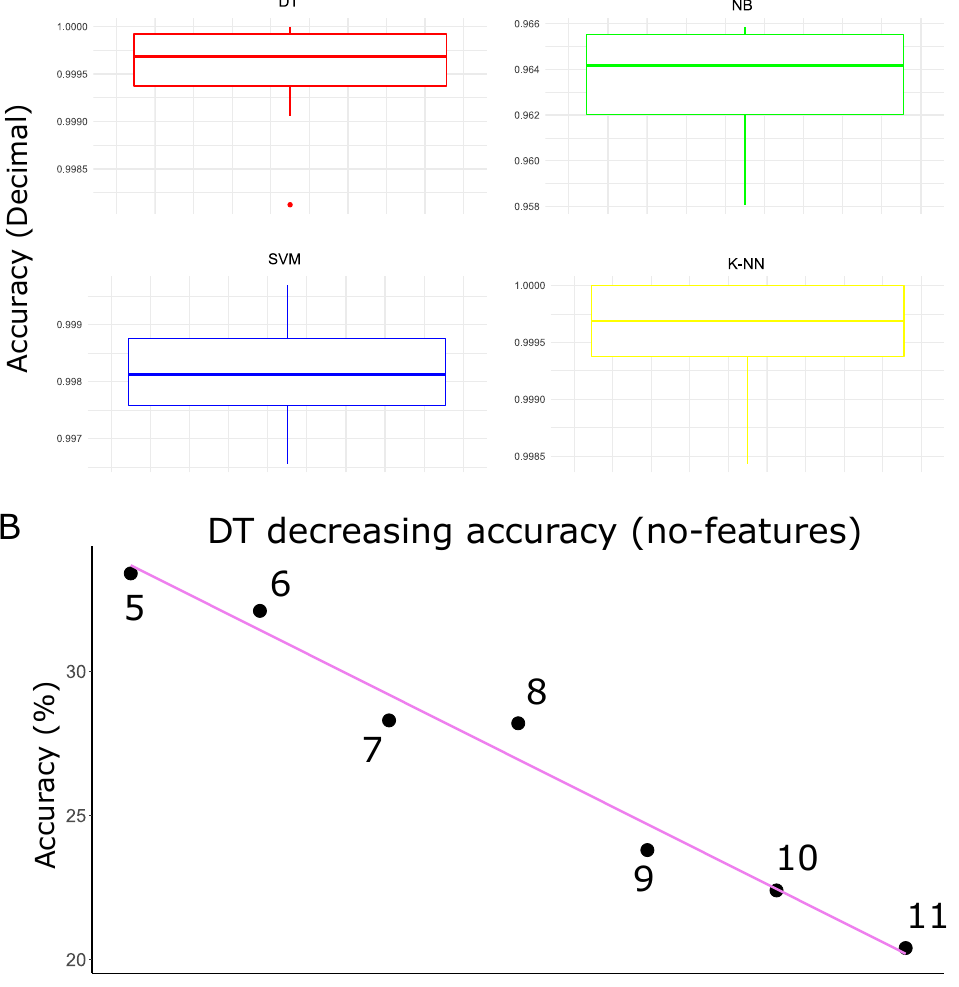
Figure 5. ( A ) The top four panels with boxplots show the classifier performances using 10-fold cross-validation; thus, each panel displays a specific classifier. The y-axis shows validation accuracy in decimal points. The features were selected and extracted to train the model from 5 to 11 classes, and a 10-fold cross-validation was performed before the performance evaluation with testing data. The class numbers were also changed to test the sensitivity of accuracy. ( B ) The lower panel shows the relationship between the number of classes and the accuracy of the DT classifier on data without features. The x-axis shows the number of clusters and the y-axis shows percentage accuracy. The DT accuracy decreased when the number of clusters or classes increased, especially when features were not selected and